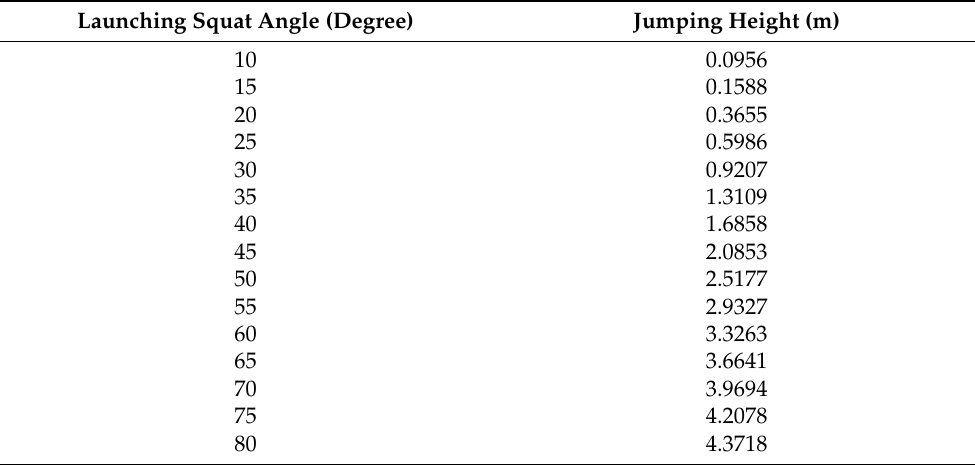
Figure 7. Modified Simulink block diagram for landing energy absorption. Table 1. Simulated jump height at different launching squat